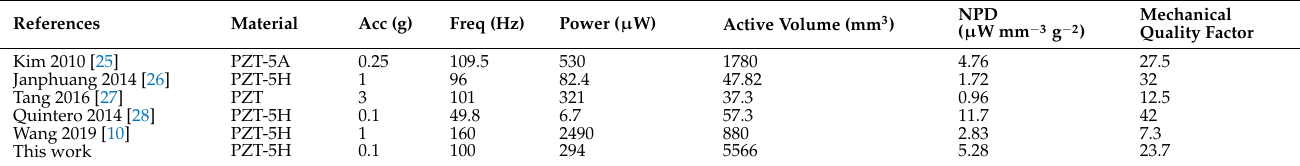
Table 3. The performance comparison of various PVEHs.